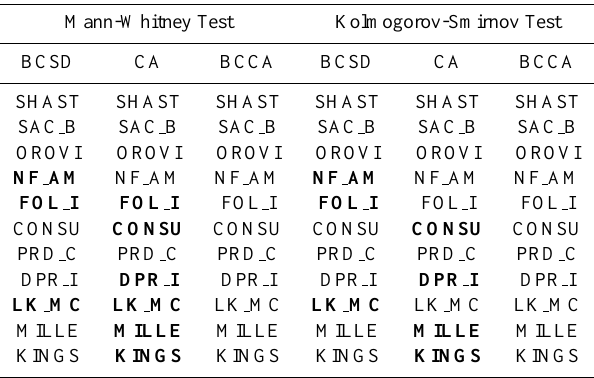
Table 2. Statistical test results for BCSD, CA, and BCCA for annual flow volume simulations. A gauge name in bold face in- dicates that the downscaled streamflow using the indicated tech- nique differs from the observations. Two tests are used: the Mann- Whitney U (also referred to as the Wilcoxon-Mann-Whitney), and the Kolmogorov-Smirnov 2-sample test (both tests performed at p = 0 . 05).